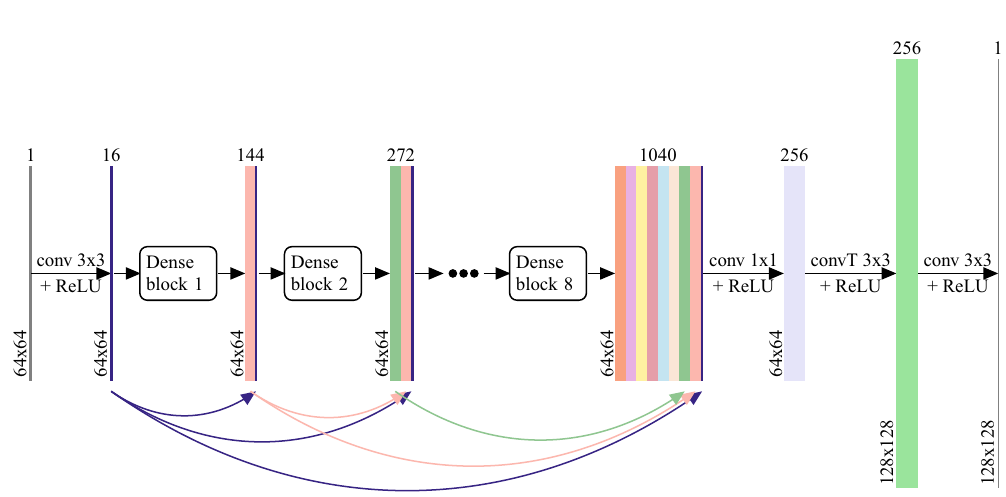
Figure 2. The SRDenseNet convolutional neural network 25 that is used to carry out single image super- resolution on low-field MR